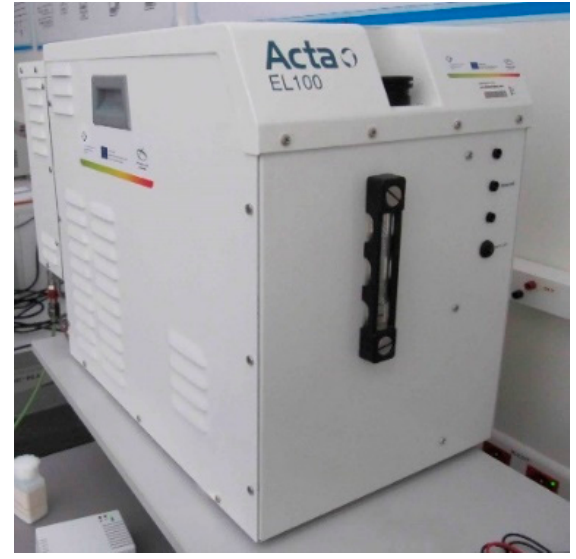
Figure 5. The ACTA EL100c hydrogen generator including a dryer.